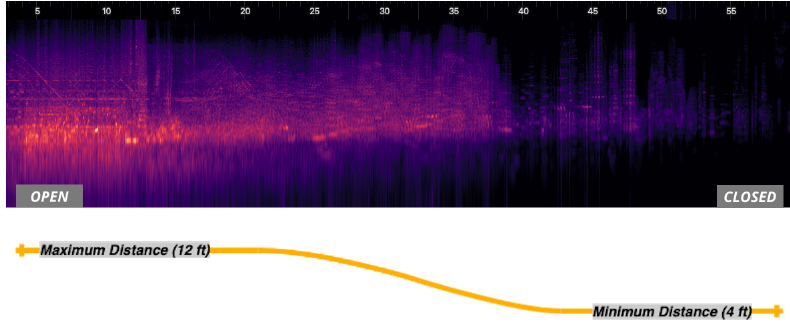
Figure 2. Spectrogram sample of interactive soundscape showing “open” to “closed” transition.